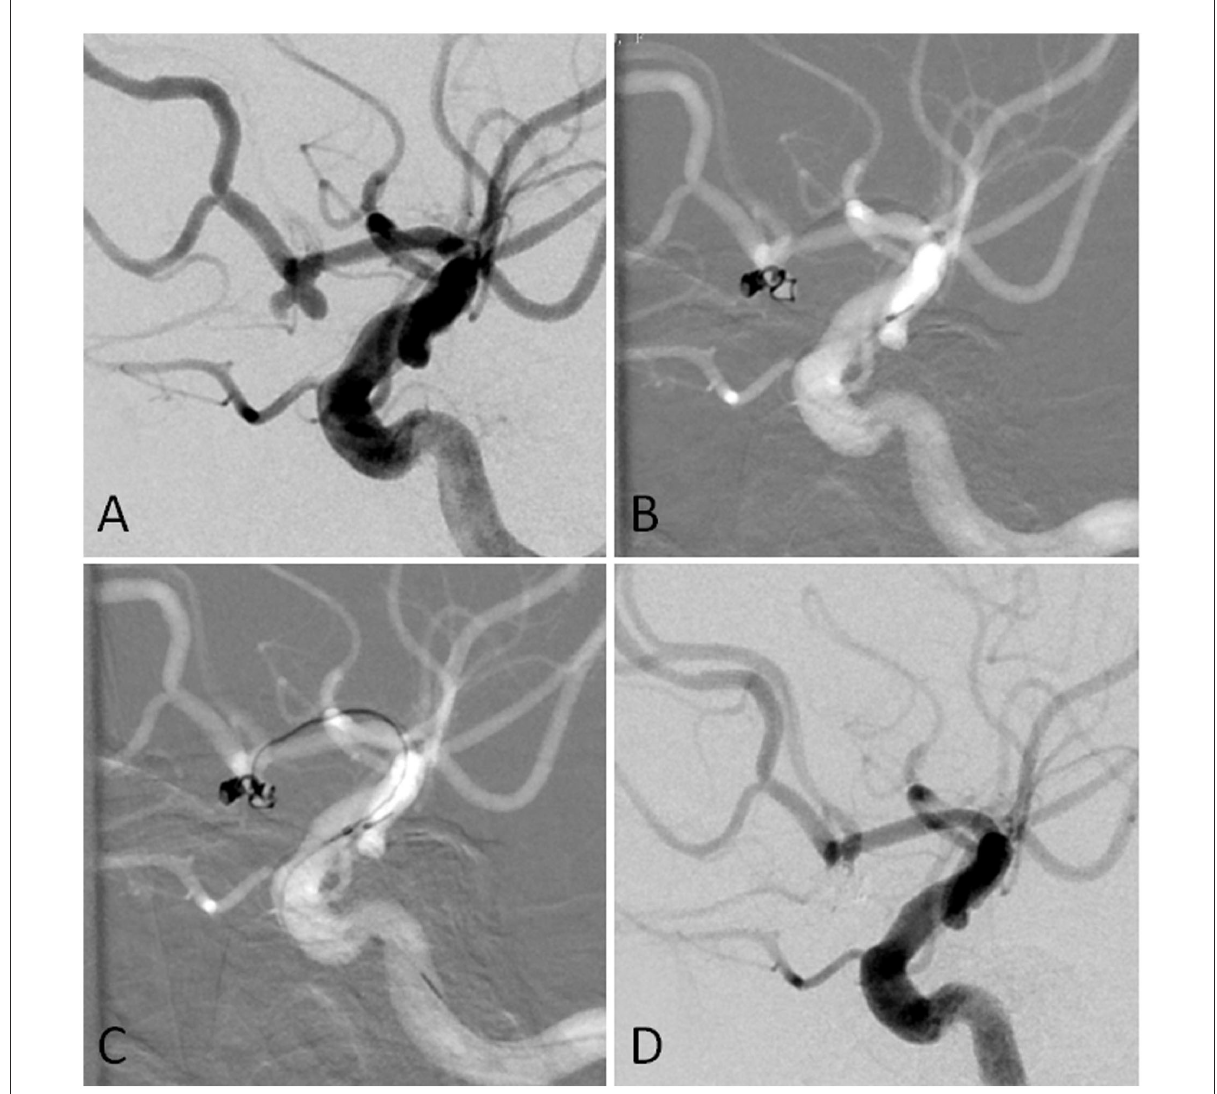
FIGURE1 (A) The angiographic imaging showed AcomA aneurysm with the daughter sac. (B) The first was navigated into the left sac of the aneurysm. The first coil was fully advanced into the aneurysm. Part of the first coil and the microcatheter entered into the right sac in the end. (C) Another microcatheter was navigated into the aneurysm. (D) The aneurysm was completely